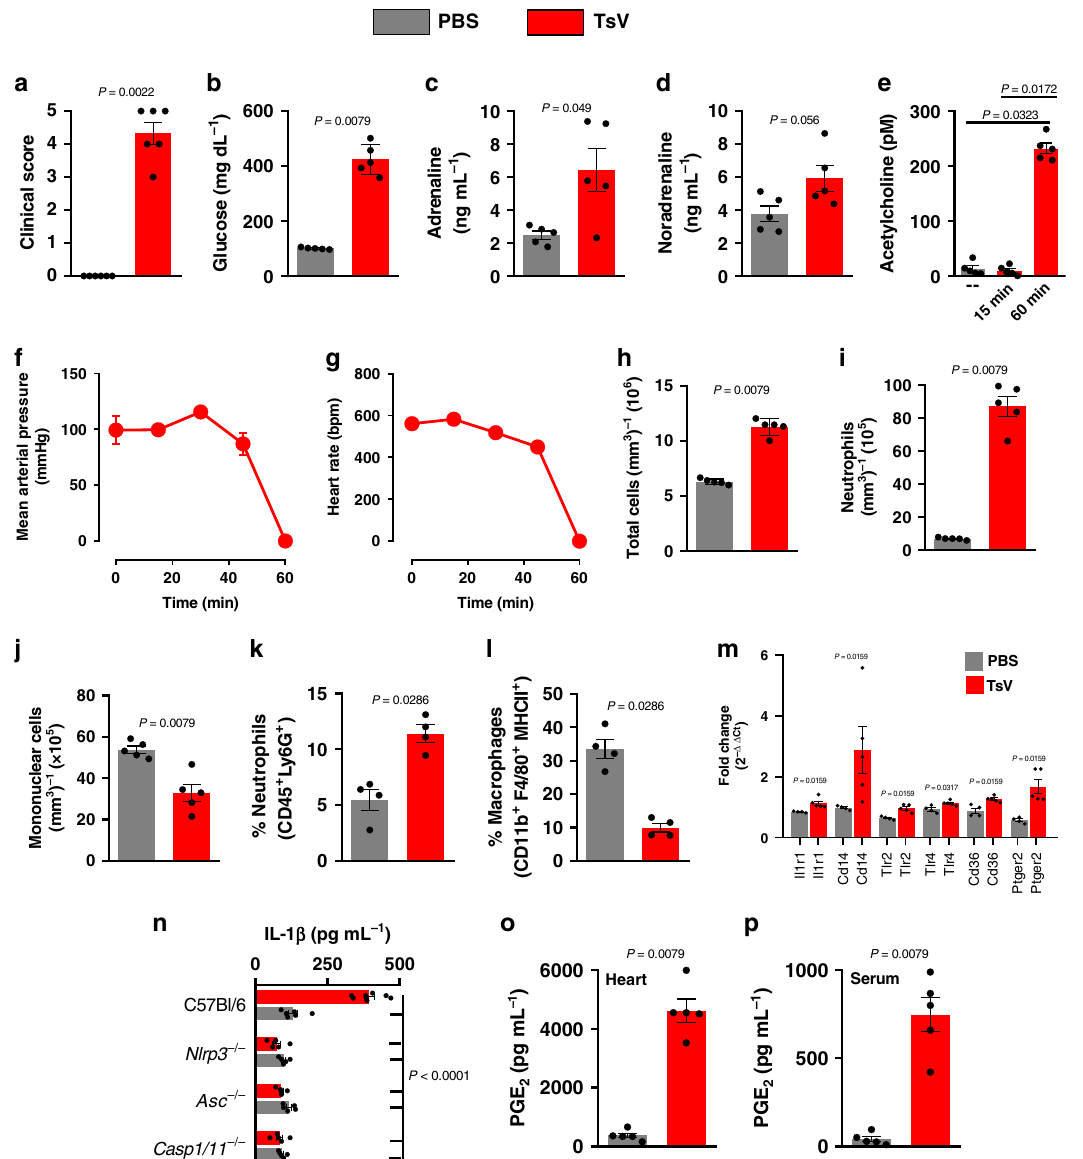
Fig. 1 TsV induces systemic manifestations and heart in fl ammation. C57Bl/6 (or indicated strain) mice were challenged with PBS or with a lethal dose of TsV and observed for 60 min, or the time indicated. At the time speci fi ed, blood was collected for the measurements. a Intense sweating, ocular secretion, nasal secretion, convulsion, and lethargy were recorded in order to compute a clinical score. b Glucose concentration in plasma, 60 min after the stimuli ( a , b , n = 5 – 6, one representative of three experiments). c Adrenaline and d noradrenaline in plasma were quanti fi ed by HPLC, 60 min after the stimuli. e Acetylcholine in plasma was quanti fi ed using a commercial kit 15 or 60 min after the stimuli ( c – e , n = 5, one representative of three experiments). f Mean arterial pressure and ( g ) heart rates were monitored for 80 min ( n = 3, one experiment). h Total leukocyte, i neutrophil, and j mononuclear cell counts in peripheral blood collected 60 min after the stimuli ( h – j , n = 5, one experiment). k Percentage of neutrophils (gated as CD45 + Ly6G + ) and l macrophages (gated as CD45 + F4/80 + MHCII + ) assessed by fl ow cytometry of cell suspensions from a heart harvested 60 min after stimuli ( k , l , n = 4, one experiment). m Heart gene expression ( n = 4 for PBS and n = 5 for TsV from one experiment). n The concentration of IL-1 β in heart homogenates of C57Bl/6, Casp1/11 − / − , Nlrp3 − / − , and Asc − / − mice ( n = 5 – 8, one experiment). PGE 2 concentration in ( o ) heart homogenates and in ( p ) serum ( n = 4 – 5, representative of two experiments). In all experiments, mice were inoculated with a lethal dose of TsV (180 µ g kg − 1 i.p./300 μ l, red bars/lines) or the same volume of PBS (300 μ l, i.p., gray bars). Data are expressed as means ± SEM. Unpaired Student ’ s t test with Mann – Whitney were applied to panels a – d , h – m , o , p , and one-way ANOVA followed by Bonferroni ’ s multicomparison test for panels e , m . Exact P values are expressed in fi gures, with P < 0.05 was considered statistically signi fi